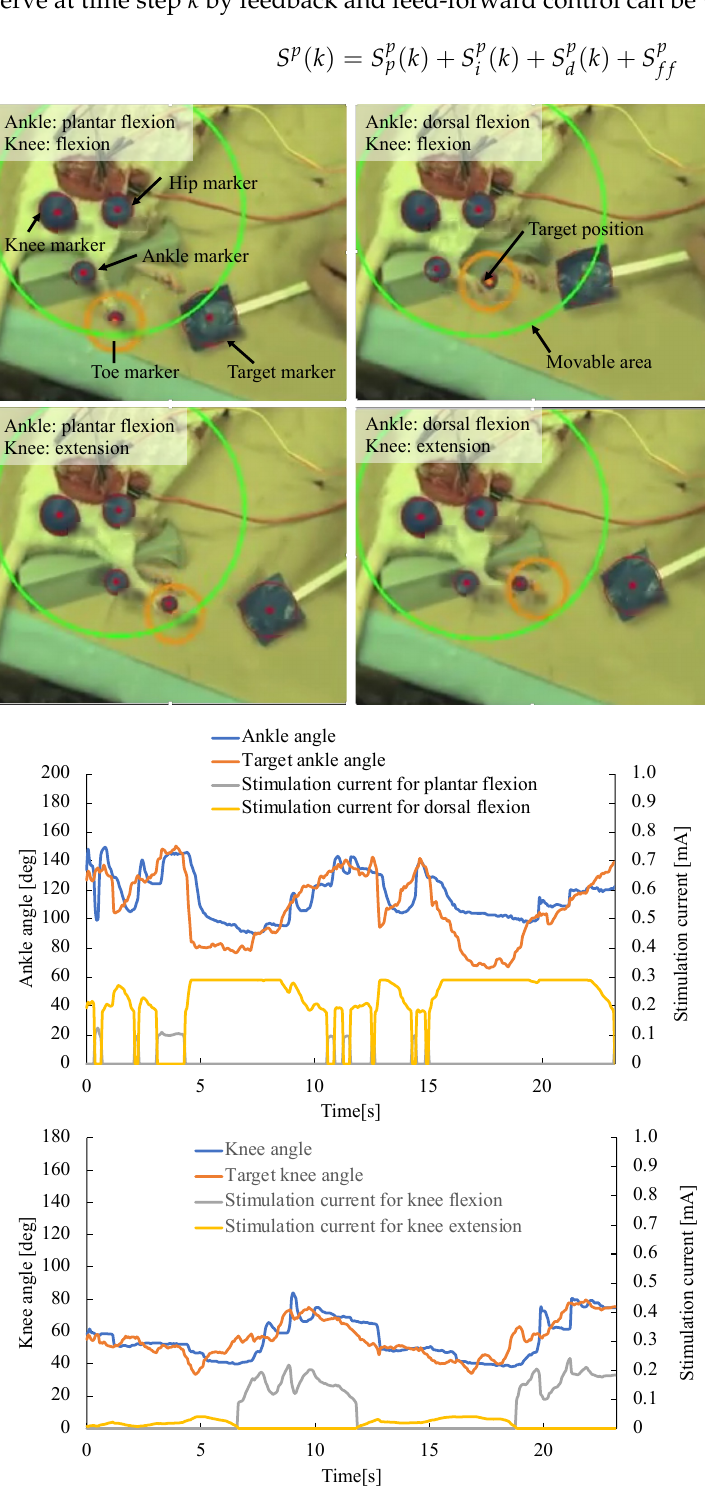
Figure 8. Experimental results about visual feedback control of rat knee and ankle joints. The lower two graphs indicate joint angle, target joint angle, and stimulation currents to the nerves during the